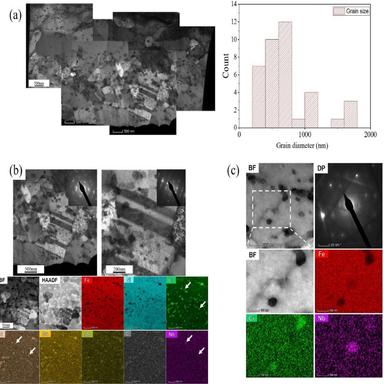
(a) Panoramic bright field TEM images showing the microstructure of alloy 709 after the tensile test at 700 C. (b) Bright field TEM images and elemental mapping showing the presence of a high density of (Cr, Mn, Mo)-rich carbides not only within grains but also at grain boundaries; (c) Bright Field TEM images showing a dislocation pinned by two Crrich and Nb-rich precipitates.